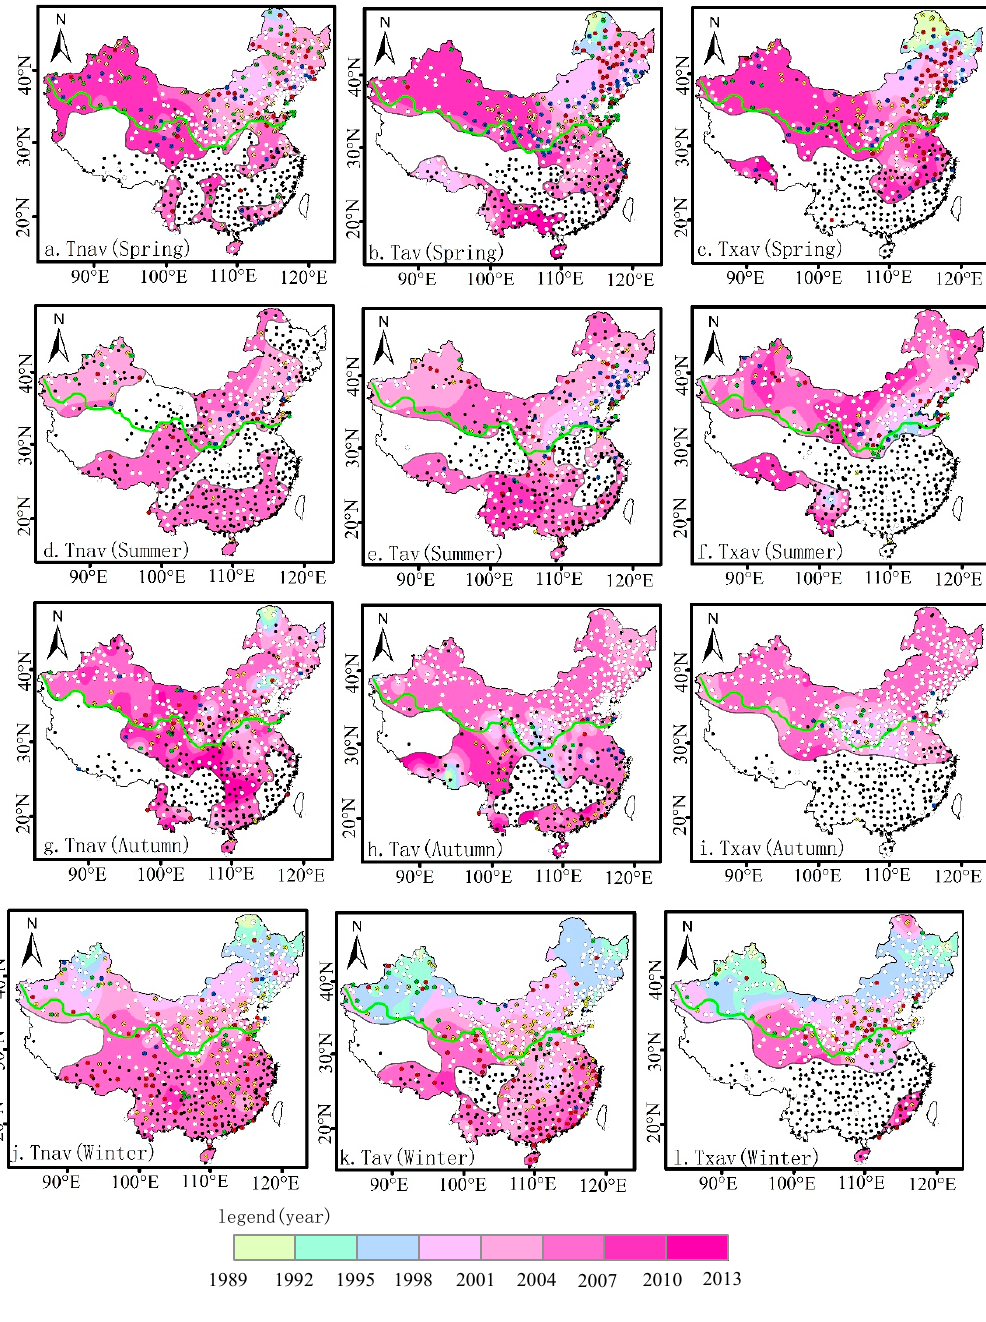
Figure 4. Spatial distribution of the hiatus years for the three temperature types in each season in the study area.